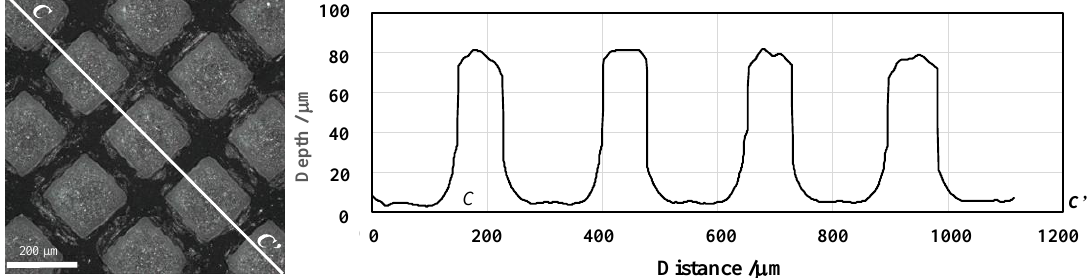
Figure 12. Measured surface roughness profiles by three-dimensional laser profilometer. ( a ) Surface roughness along A –A’ in Figure 9b, and ( b ) surface roughness along B –B’ in Figure 10b. Figure 13. Height distribution of the multi-punch array measured along the line C –C’ . The average punch height was 76 μ m.